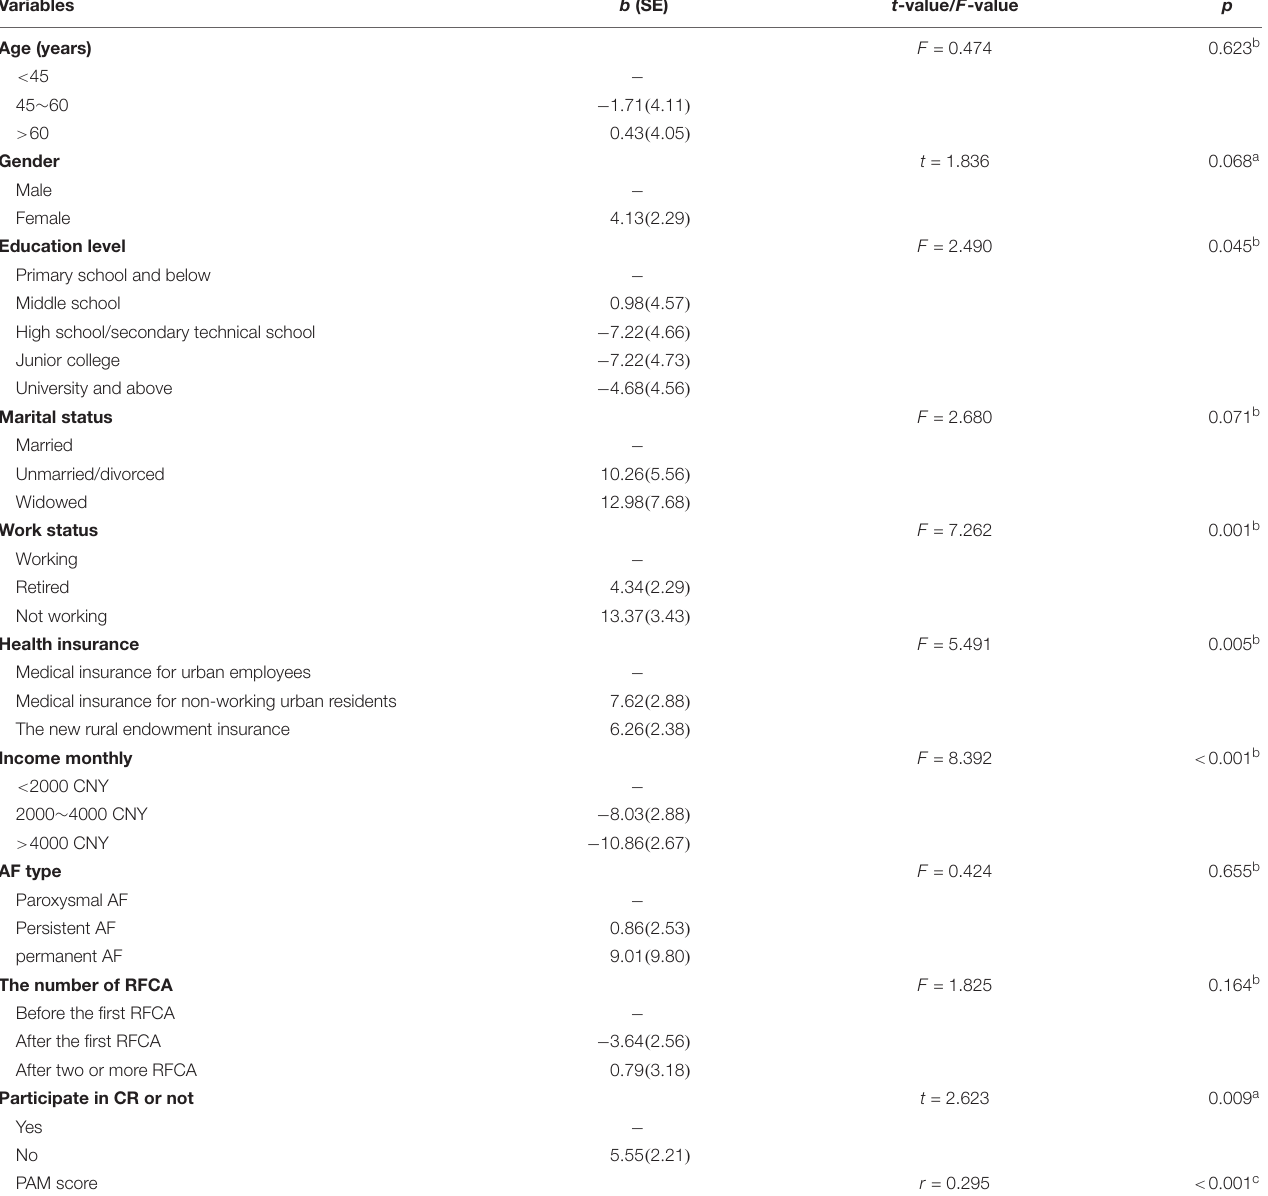
TABLE 3 | Univariate analysis of variables against AFEQT ( n = 190).